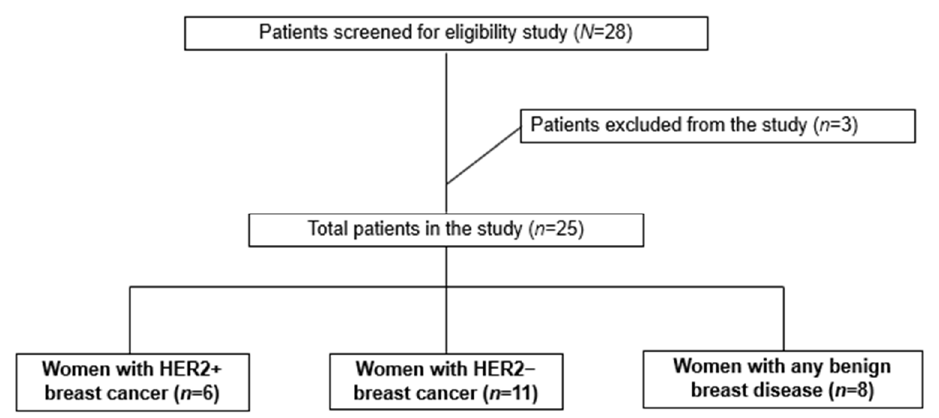
Figure 1. Study flowchart.